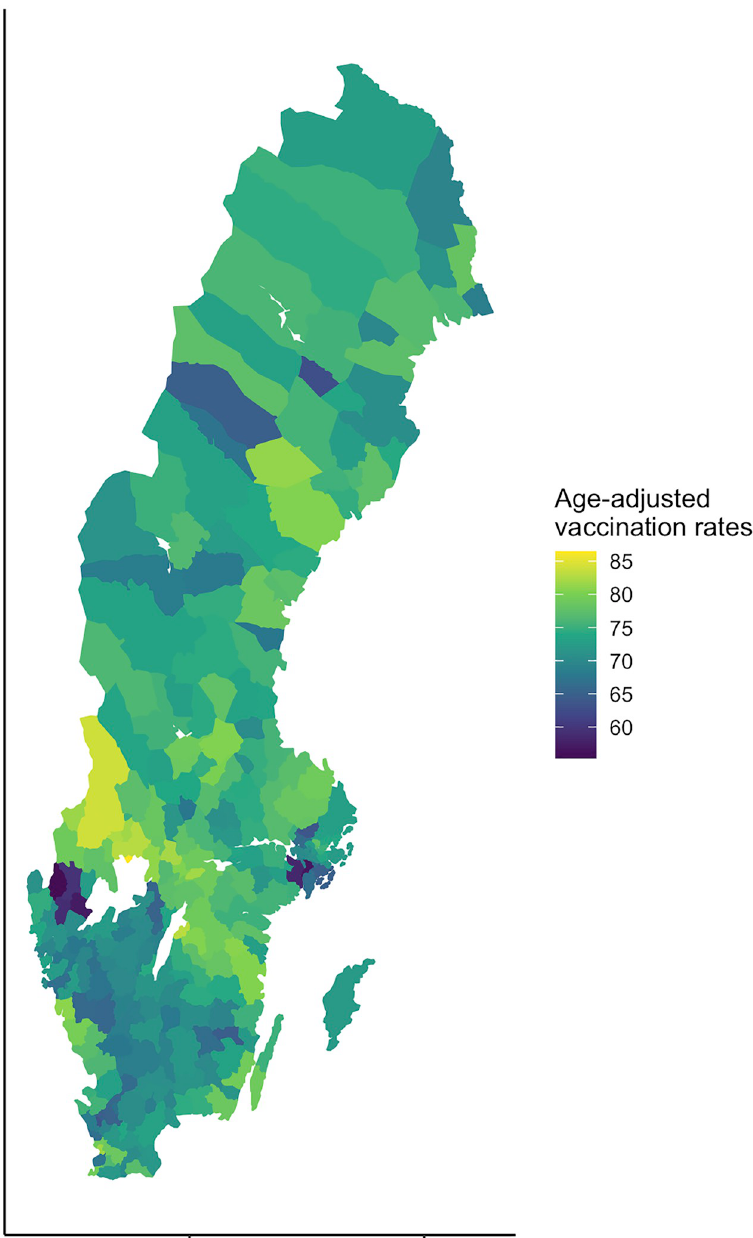
Fig 1. Map of Sweden where municipalities are colored based on age-adjusted vaccination rates (in %). Source: Statistics Sweden and the Swedish Public Health Agency. Map layer: SWEREF99 (https://www.lantmateriet.se/